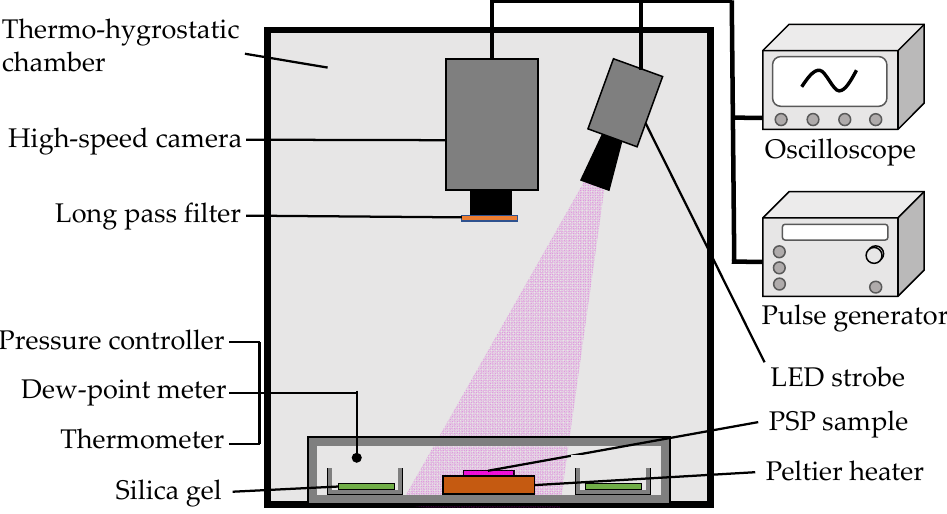
Figure 2. Schematic diagram of the variable pressure chamber.